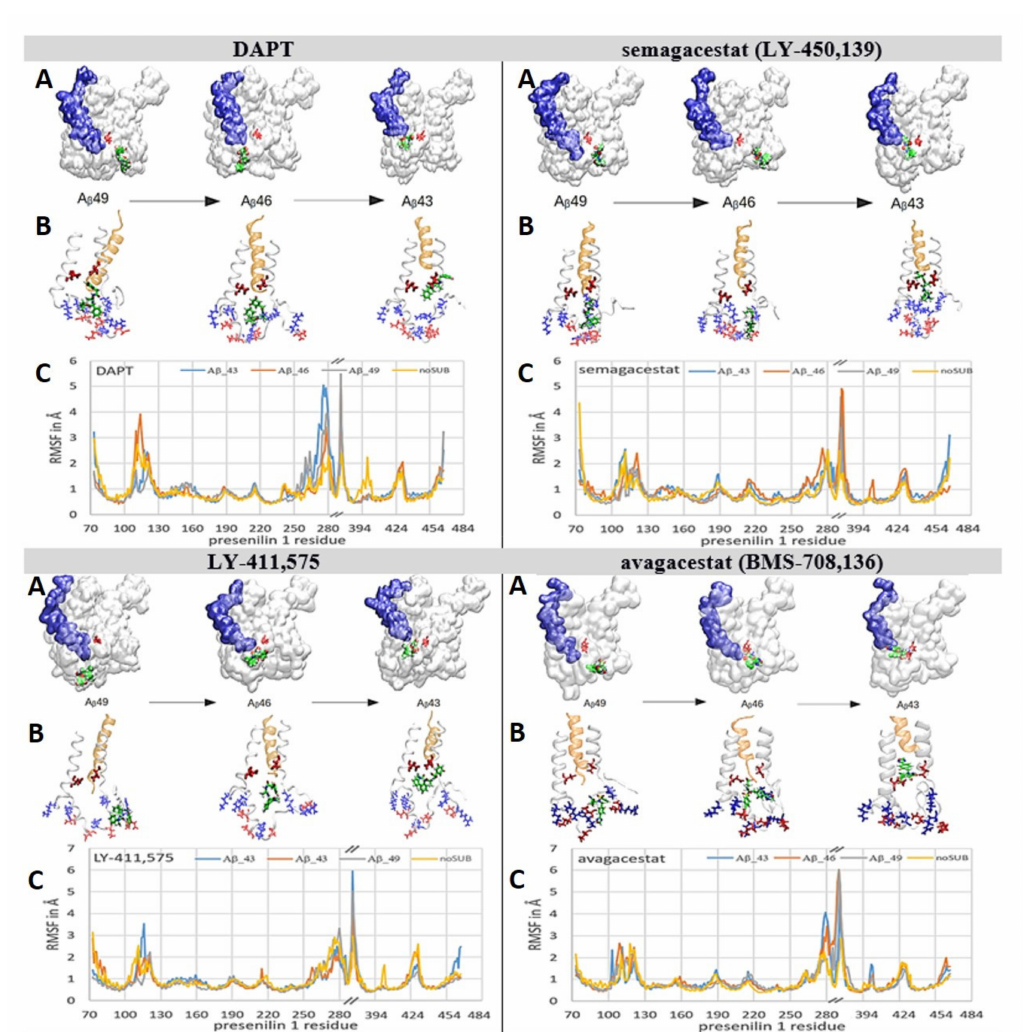
Figure 7. ( A – C ). Biphasic drugs can bind to γ -secretase and selectively interfere with the processive proteolytic cleavages. We used all-atom molecular dynamics studies [51] to analyze whether the molecules of biphasic drugs can penetrate into the active site tunnel when γ -secretase is in a complex with different A β catalytic intermediates. With all four drugs, the deepest penetration is observed with A β 43, and the lowest penetration is observed with A β 49. The penetrations are depicted using the presenilin structures [38], and quantitatively using RMSF values as a function of amino acid positions [40,41]. ( A ) The presenilin structures are shown as a white transparent surface in order to make the structures below the surface visible. Buried underneath the surface in the active site tunnel are different A β catalytic intermediates (blue surface) and the active sites Asp 257 and Asp 385 (red licorice). The drugs are shown as green Van der Waals models. ( B ) The white ribbon models depict amino acids 240 to 394 in presenilin structures. The gold ribbon models depict different A β catalytic intermediates. The positively-charged amino acids are shown as blue licorice; the negatively-charged amino acids are shown as red licorice, including the active sites Asp 257 and Asp 385. The drugs are depicted as green licorice models. ( C ) The RMSF values as a function of the amino acid positions show how biphasic drugs can affect different structural parts to a different extent with different A β catalytic intermediates